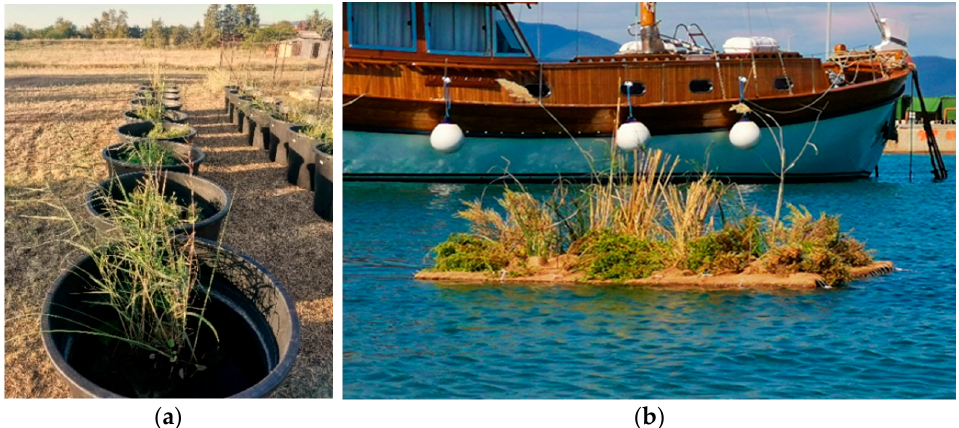
Figure 1. Floating wetlands for marine water pollution control within the framework of the AT- LANTIS project. ( a ) Lab-scale units of floating wetlands, ( b ) Pilot-scale floating wetland established at Ierissos Port in Northern Greece.